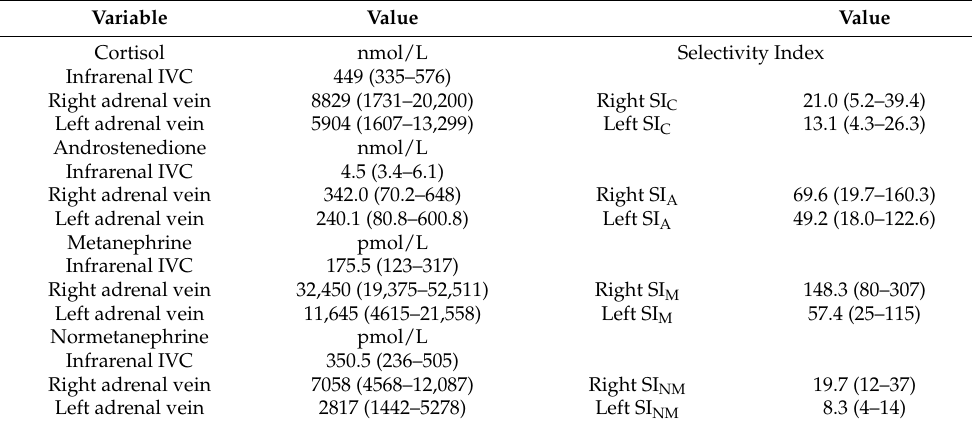
Surgically Treated ( n =